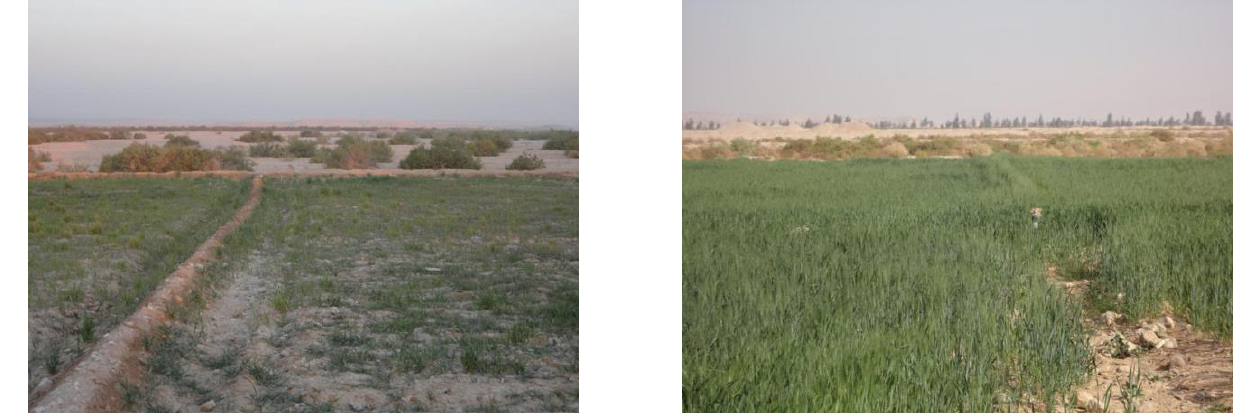
Figure 1. Photos showing two reclaimed agricultural fields near Qena, Upper Nile Valley, Egypt.